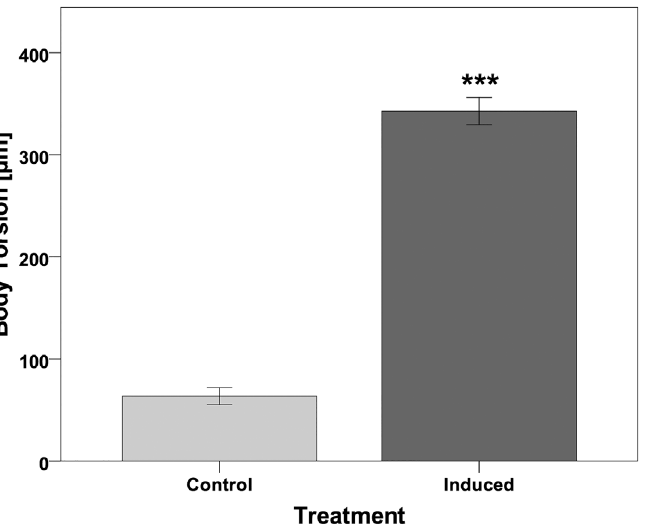
Fig 2. Comparison of the body torsion in non-predator-exposed (Control) and predator-exposed (Induced) primiparous Daphnia barbata . Body torsion is here defined as the sum of helmet and tail spine deviation from the body axis. The error bars show the standard error of Mean (SE), the asterisks indicate the significance level ( *** P < 0.001) based on a F-Test ( F (1, 22) = 264.09).